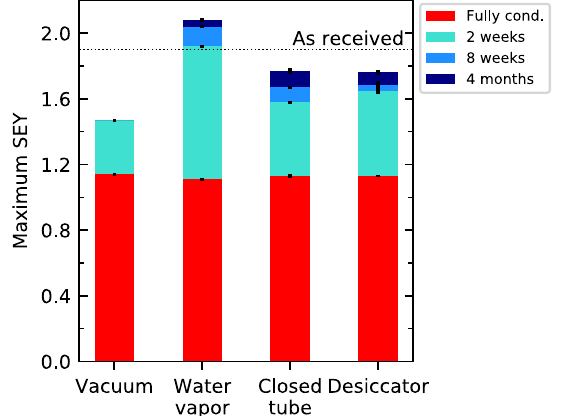
FIG. 7. Evolution of the maximum SEY of samples stored in different atmospheres after full conditioning. The vacuum storage was performed for only 2